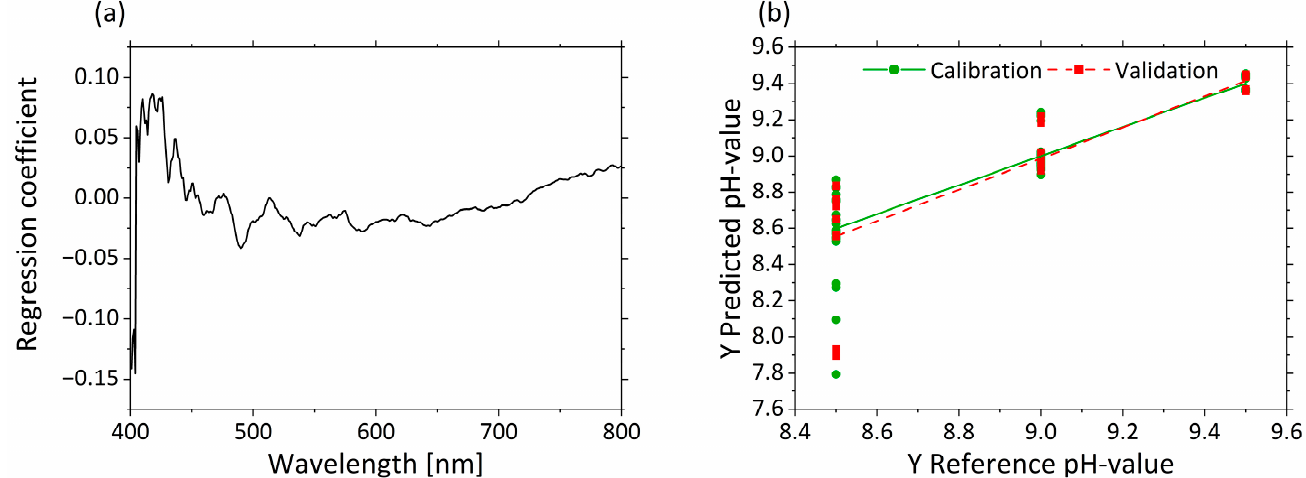
Figure 8. PLS-R with three factors for pHs based on µ’ s -spectra. The regression coefficients of the three-factor model are shown in ( a ). Predicted vs. reference of pHs for calibration (green) and validation (red) are displayed in ( b ).